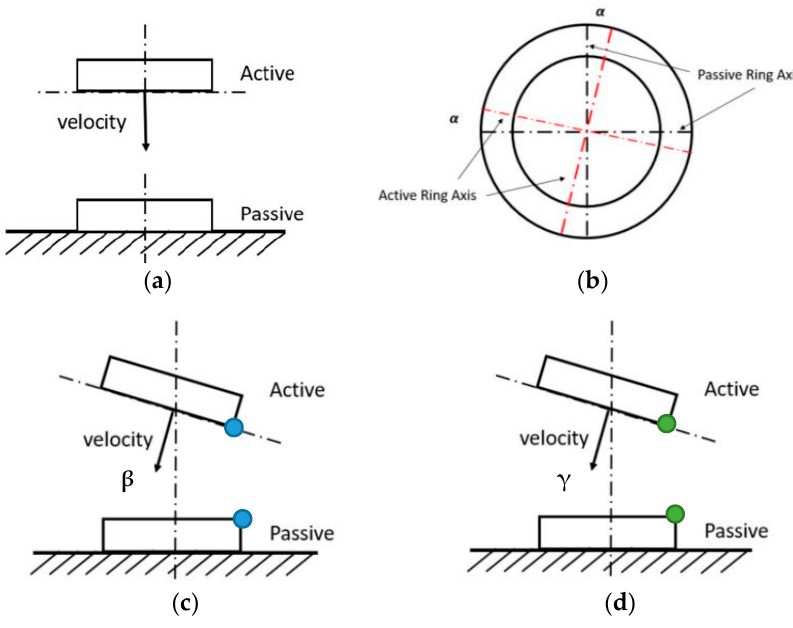
Figure 6. The four test cases: ( a ) Nominal case: ideal approach along vertical “Z” axis; ( b ) Non-nominal case 1: misalignment in the contact plane; ( c ) Non-nominal case 2: misalignment out of the contact plane (edge contact); ( d ) Non-nominal case 3: misalignment out of the contact plane (vertex contact).